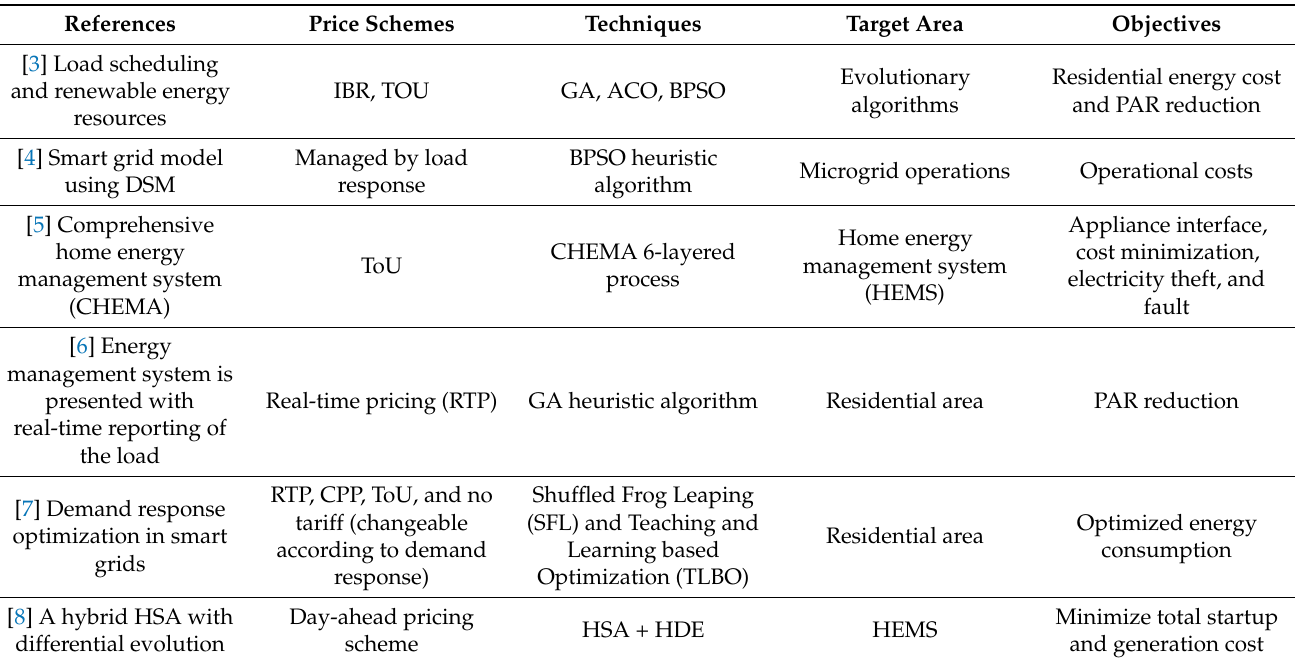
Table 2. State of the